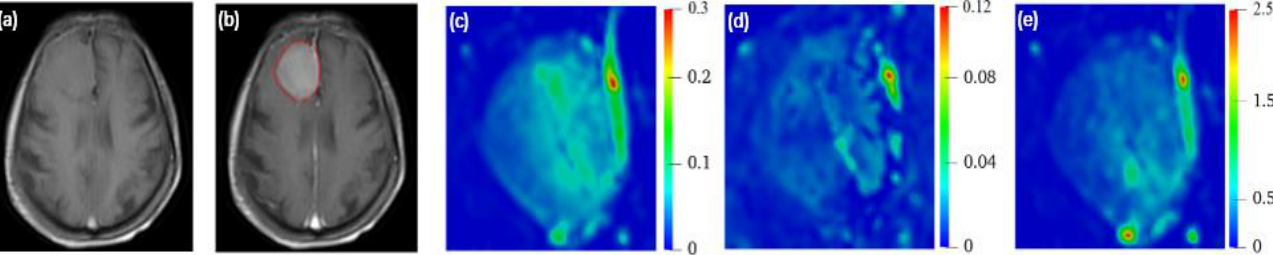
Figure A1. Tissue heterogeneous properties extracted from patient DCE-MR images. ( a ) Pre-contrast image, ( b ) post-contrast image, ( c ) tissue porosity 𝜖 ECS , ( d ) microvascular density, 𝜖 BL and ( e ) 𝐾 trans . The interface between the brain tumor and its holding tissue is marked in red in the post-contrast image.